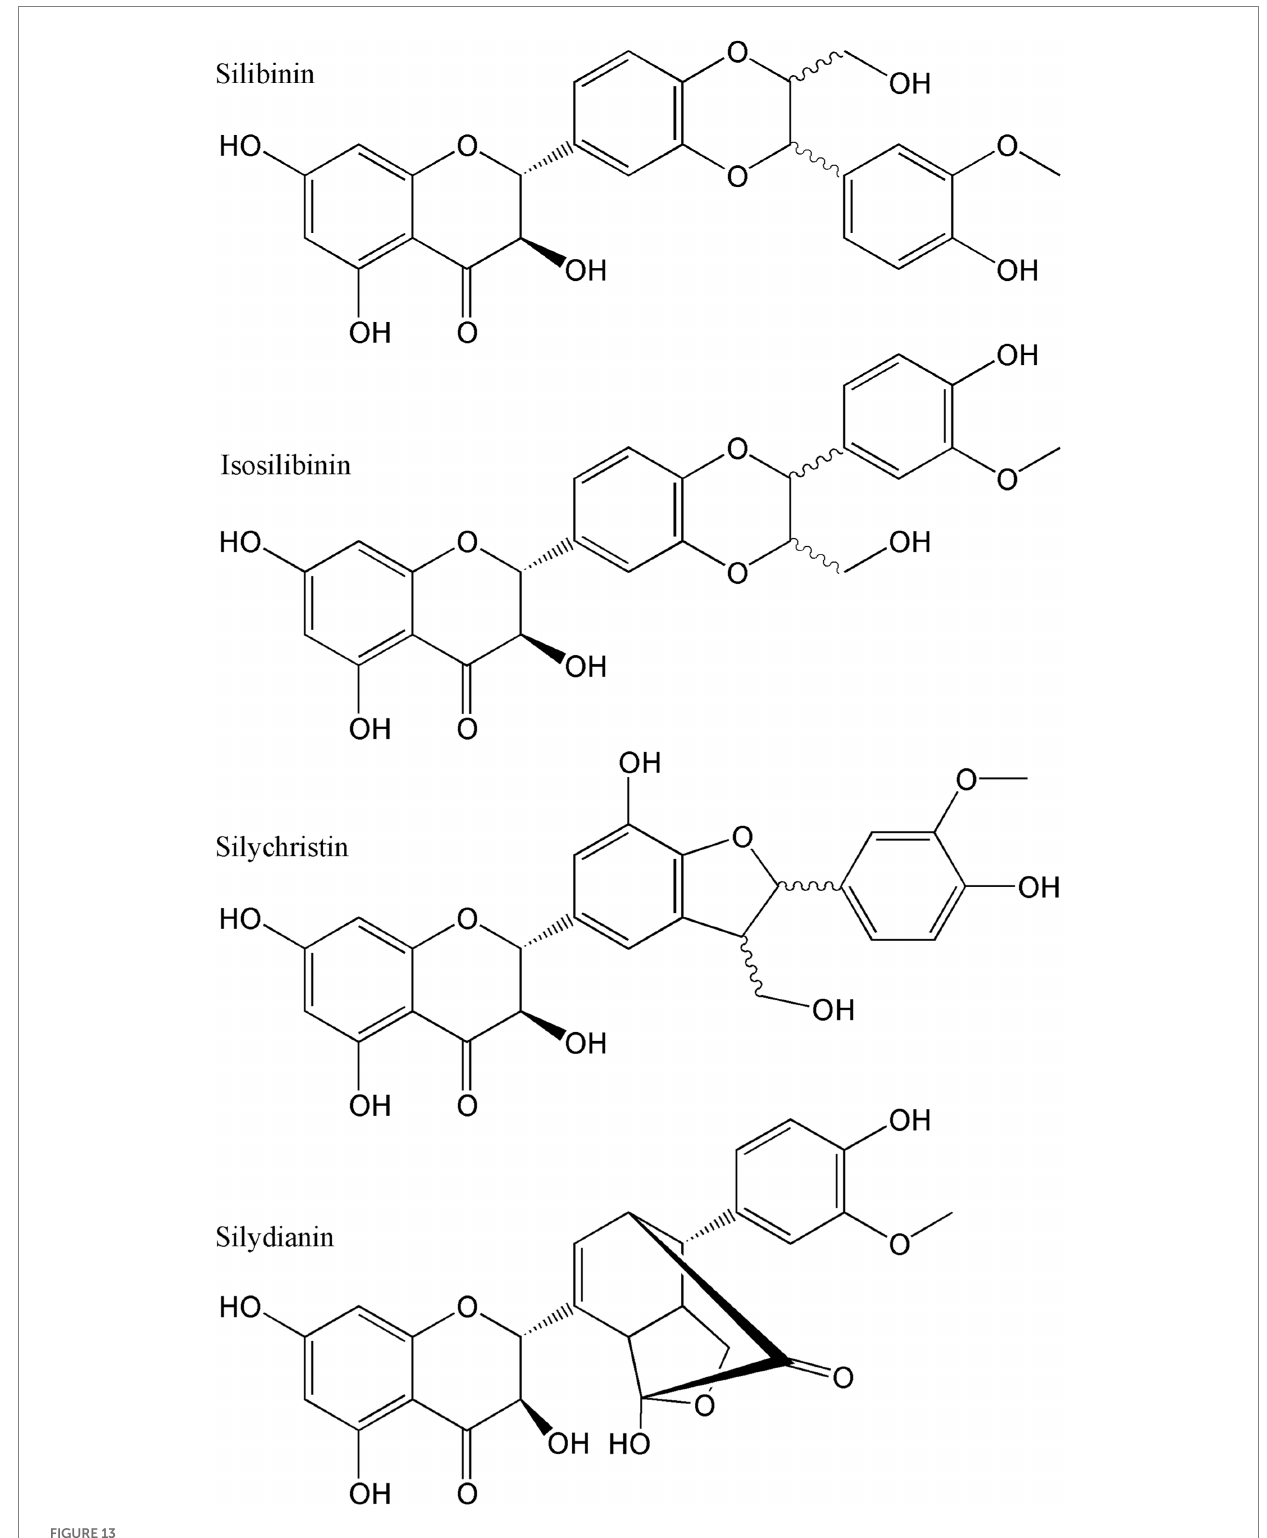
FIGURE 13 Chemical structures of some of the silymarin